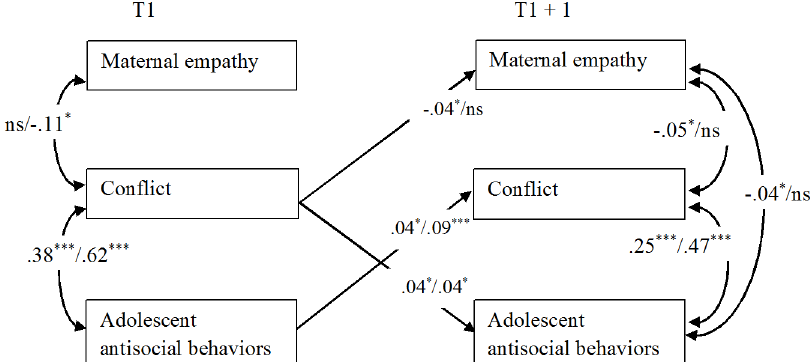
Fig 3. Significant Standardized Results of the Cross-Lagged Models Linking Maternal Empathy, Conflict, and Adolescent Antisocial Behaviors (A/M Reports). For each cross-lagged effect and correlation, the first result is based on adolescent reports (A) and the second on maternal reports (M). Since the models with time-invariant coefficients were retained as the final ones, we present only two time points (T and T+1), and all coefficients displayed represent the averaged standardized coefficients over the six time intervals. * p < .05, ** p < .01, *** p <